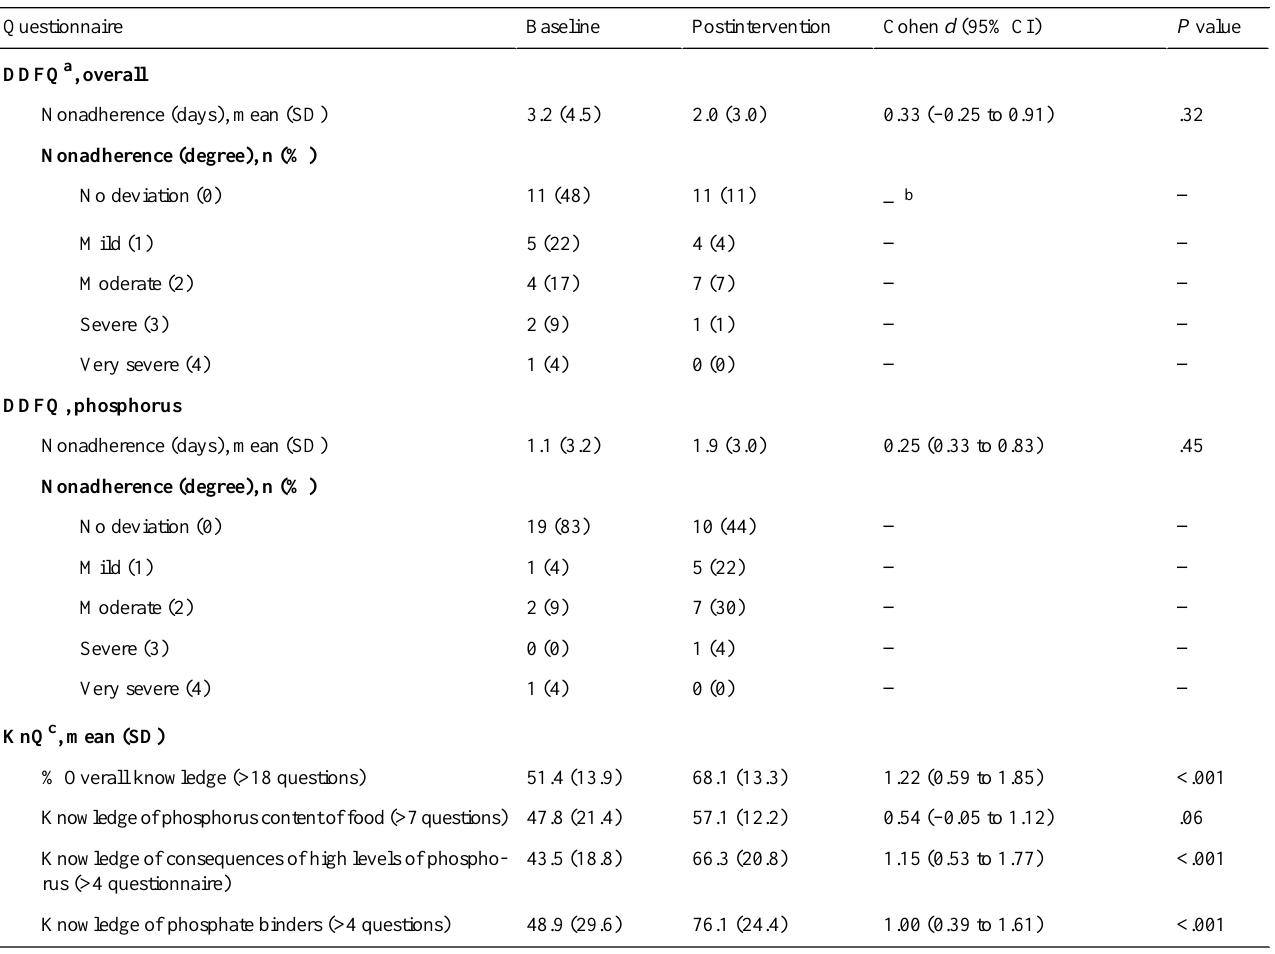
Table 2. Baseline and postintervention self-reported dietary nonadherence and dietary knowledge